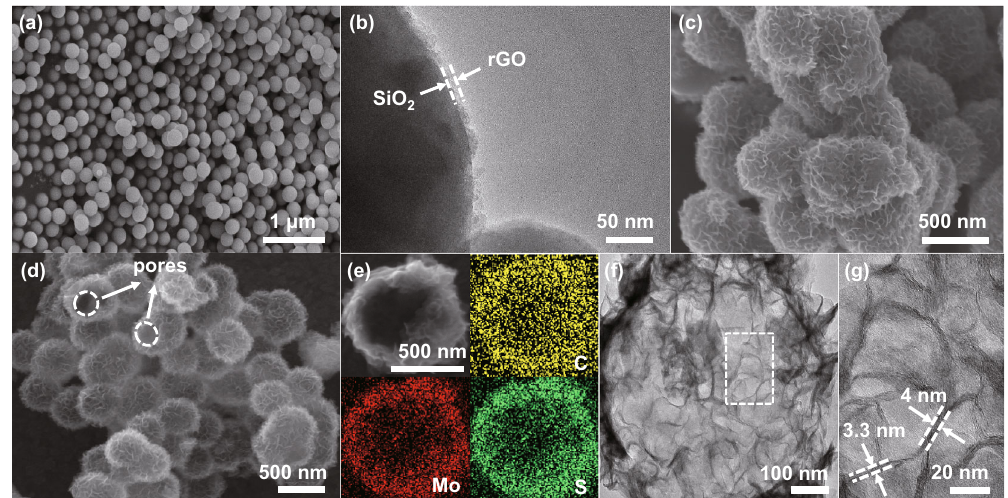
Fig. 1 The SEM and TEM images of a the SiO 2 sphere templates, b SiO 2 @GO, and c SiO 2 @GO@MoS 2 . d SEM images of the h-rGO@MoS 2 spheres. e EDS elemental mapping results of the h-rGO@MoS 2 spheres. C arises from rGO, Mo and S arises from MoS 2 . f TEM image of h-rGO@MoS 2 , and g the HRTEM image of the white area in f showing several sheets of MoS